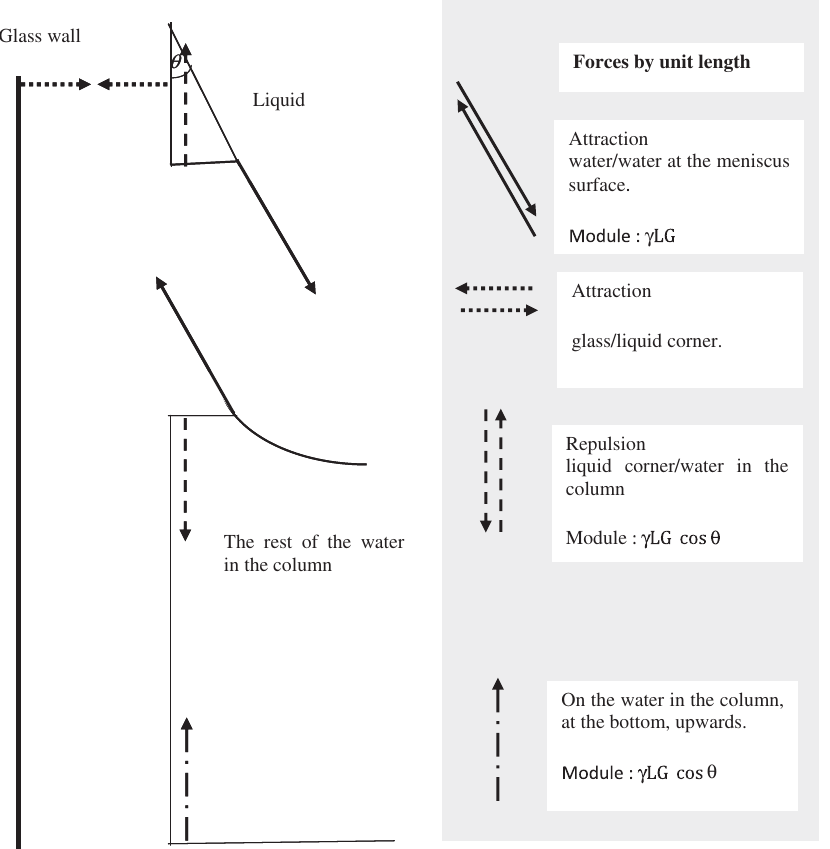
FIG. 7. Dislocated diagram of capillary ascension, in which several objects, defined by a unit length of the contact line and actually in contact, are represented separately (see text). The only complete free-body diagram (by unit length of the line of contact) is on the liquid corner. The weight of the liquid corner is negligible with respect to the other forces, and the weight of the liquid column, P is not π r 2 h g ¼ γ LG cos θ . 2 π r ). The role of gas pressure (here, atmospheric pressure) is represented (for a column of height h , P ¼ ρ eau tube tube not represented; it generates a normal force exerted on each external surface (even immersed) of the various objects in play (liquid corner, liquid column, glass wall, … ) whose total contribution to the Newtonian balances is zero as with any object located in a gas environment at a (locally) constant pressure [61,62].